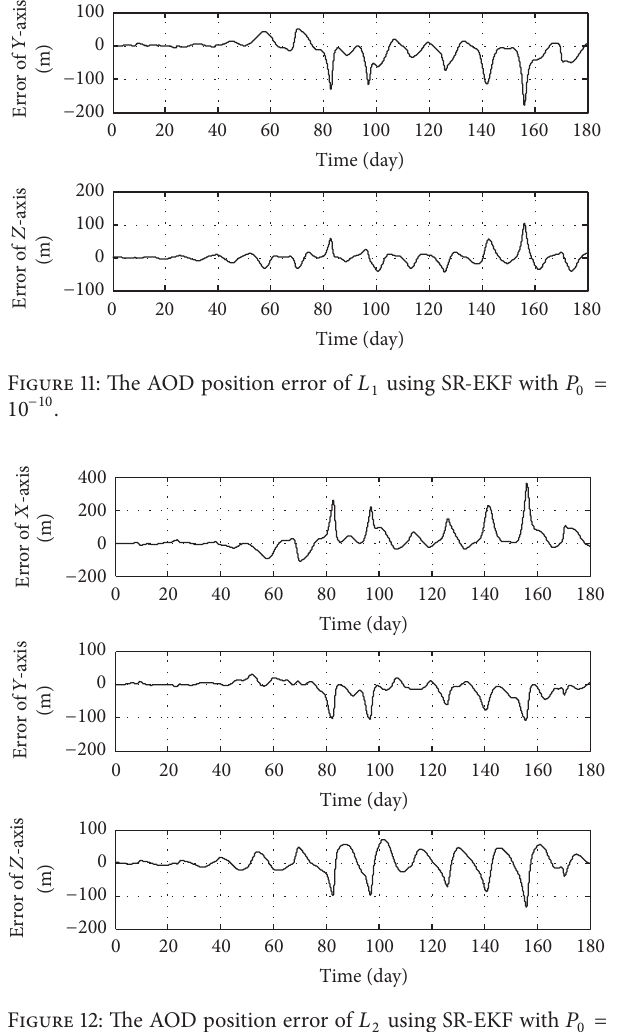
initial error variance matrix is bigger than a boundary. In our simulation, the best AOD result coincides with the 𝑃 0 = 10 −10